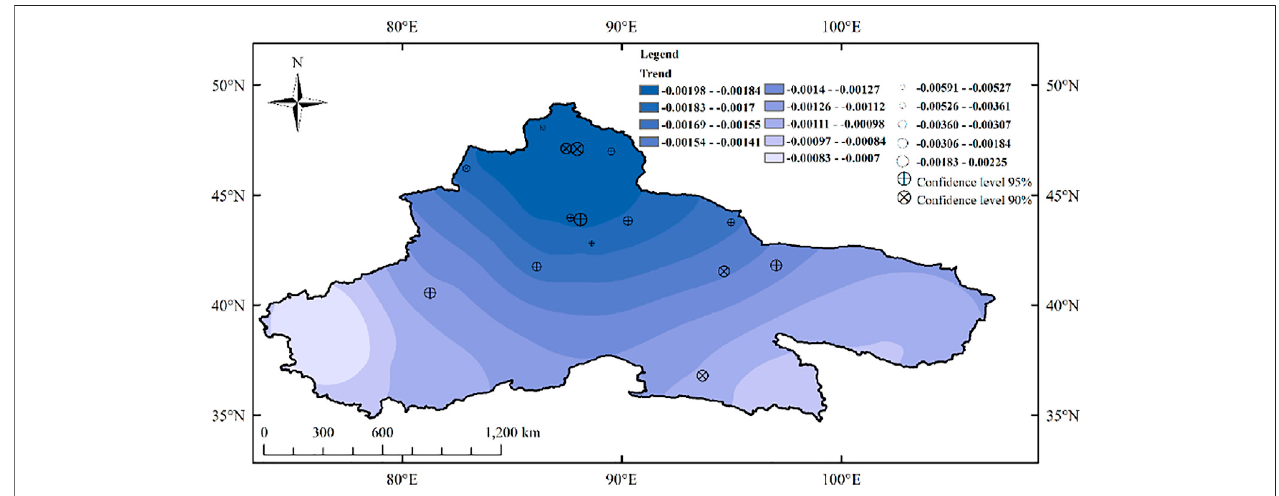
FIGURE 3 | Interannual variation of the spatial pattern of extreme precipitation concentration degree